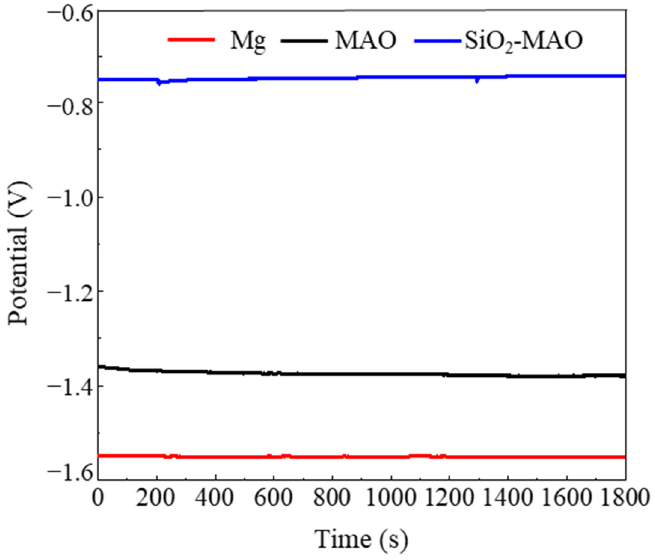
Figure 4. The OCP curves of the AM60B-Mg, MAO coating and SiO 2 /MAO coating.